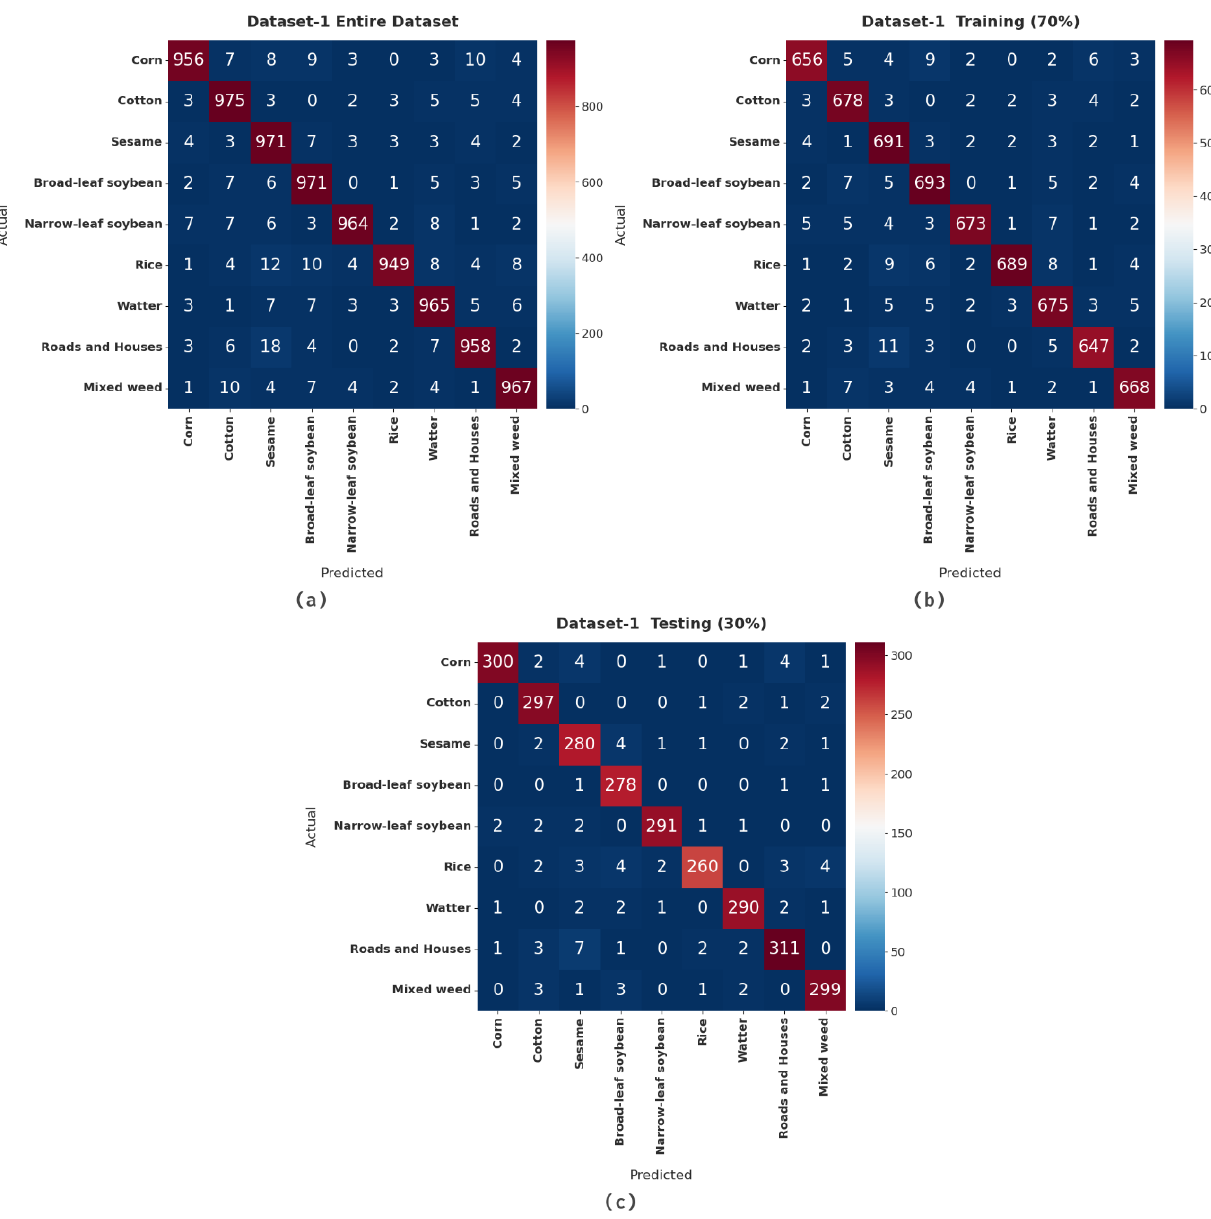
Figure 4. Confusion matrix of the SSODTL-CC technique under dataset-1. ( a ) Entire dataset-1. ( b ) 70% of Training dataset-1 and ( c ) 30% of Testing dataset-1.